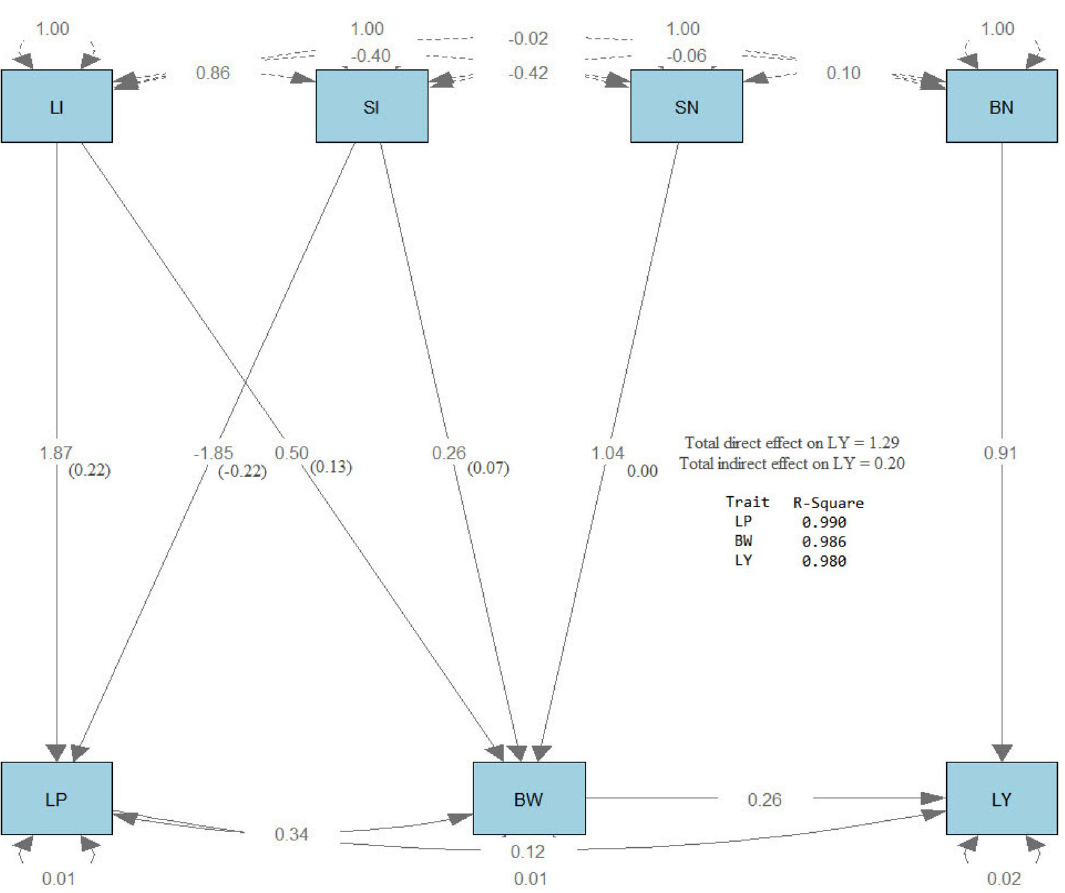
Figure 4. Path diagram of the direct and indirect effects of the studied traits in